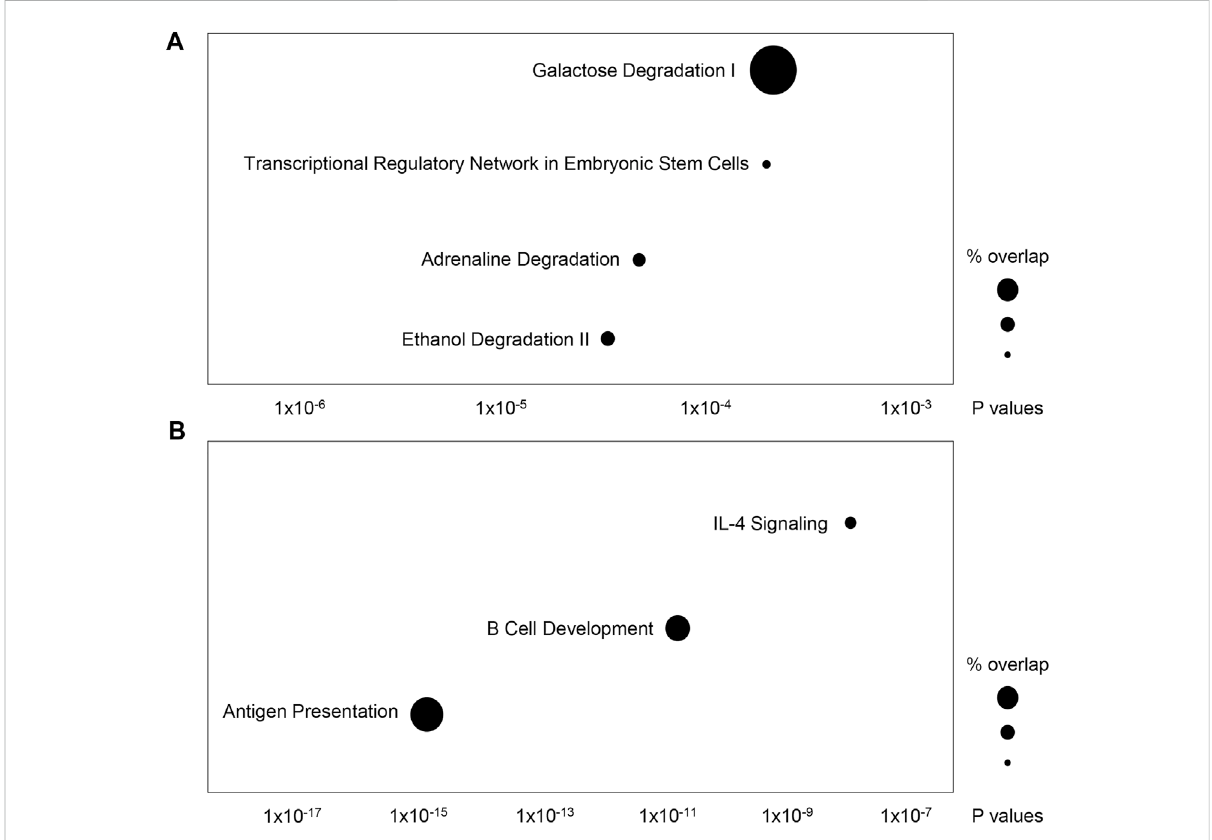
FIGURE 6 Ingenuity PathwayAnalysisofgenes regulated byAST-andALT-associated variantsintheCCHC.The topcanonicalpathways overrepresented by genes regulated by (A) AST-associated variants and their proxies, and (B) ALT- associated variants and their